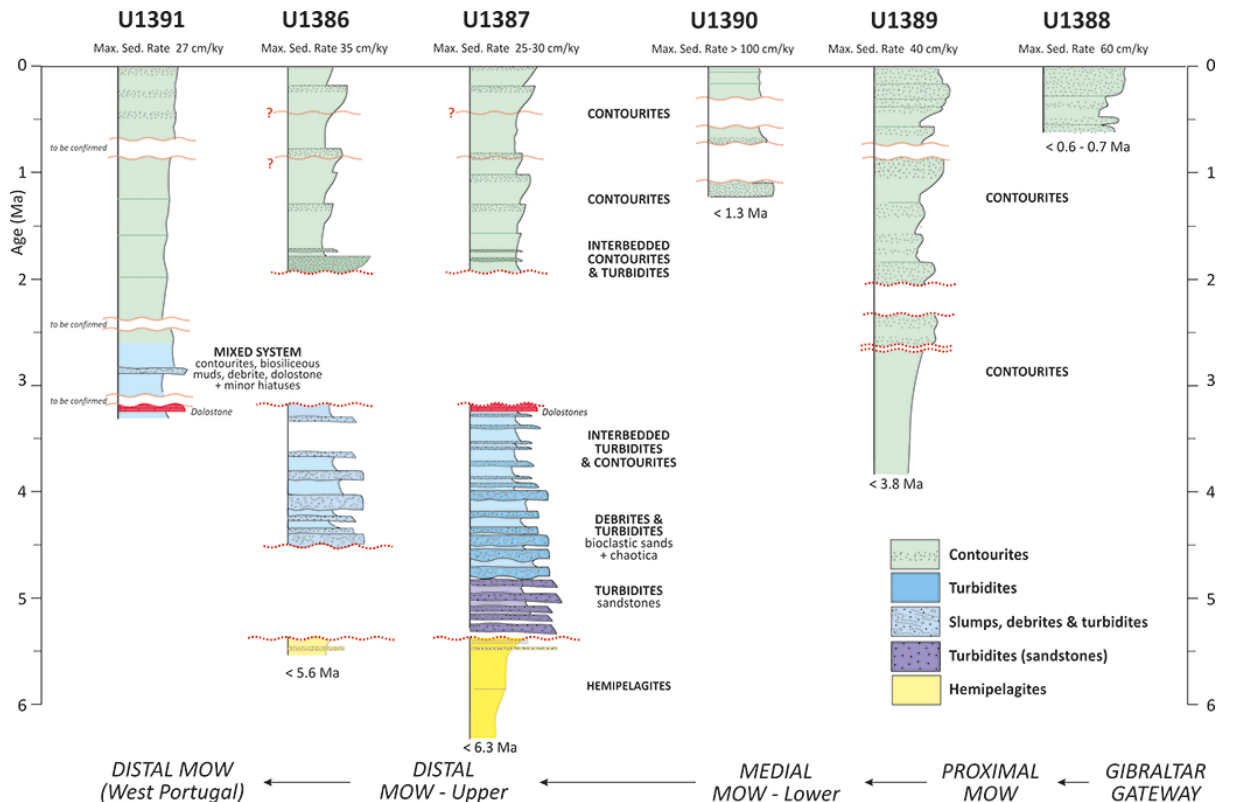
Figure 4. Lithologic summary for the sites drilled during IODP Expedition 339 in the Contourite Depositional System of the Gulf of Cadiz and west o ff Portugal. A general interpretation, including the position of principal hiatuses, is indicated. Age models are based on biostratigraphic datums and magnetostratigraphy. Sedimentation rates for the Pliocene = 15–25cmky − 1 and for the Quaternary = ∼ 30 to > 100cmky − 1 . Site location on Fig.